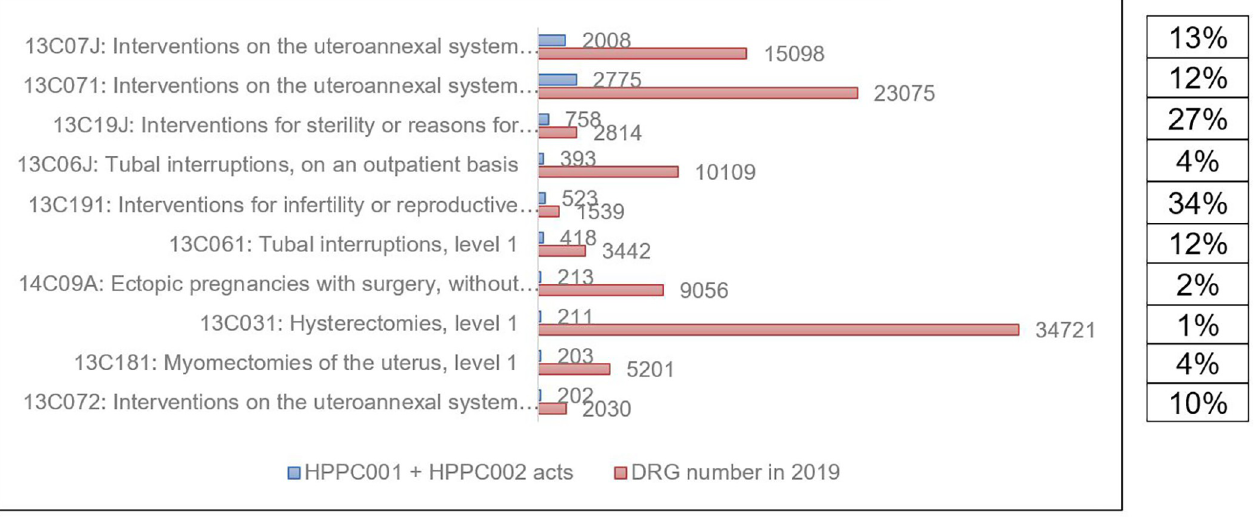
Fig 1. Main DRG according to HPPC001 and HPPC002 medical acts and percentage of both acts in the general DRG.